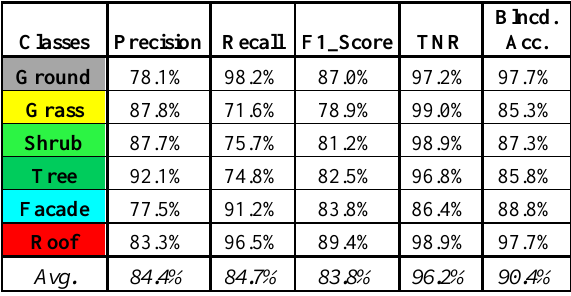
Table 4. Per class accuracy metrics, for the classification result